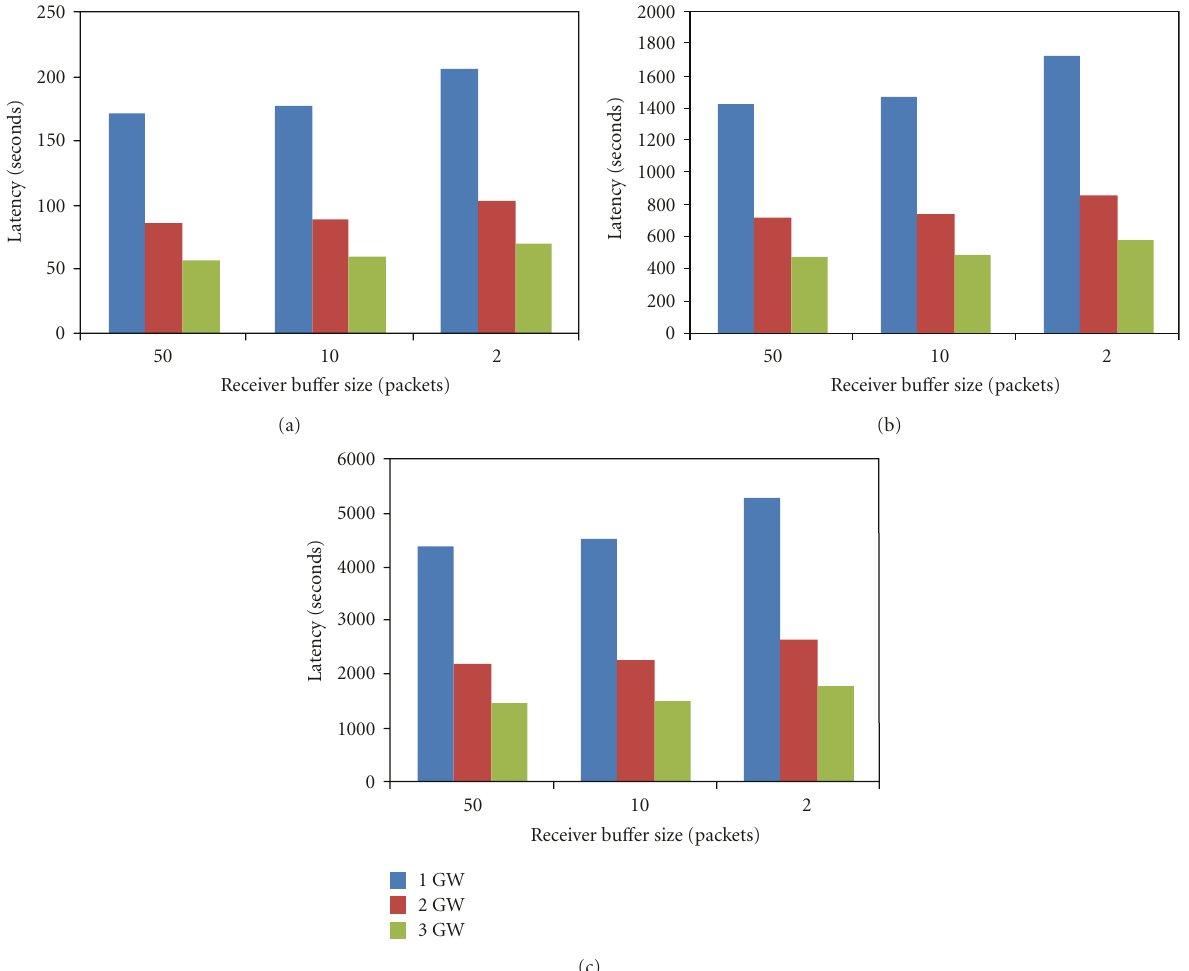
Figure 10: E ff ect of receiver bu ff er size on latency of file transfer for file sizes (a) 5Kbytes, (b) 42Kbytes, and (c)